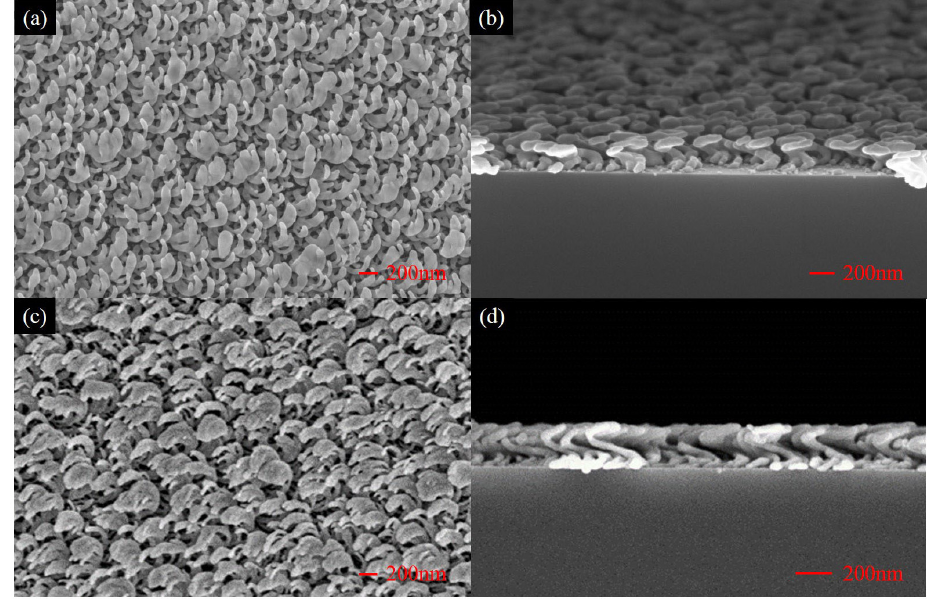
Figure 4. Top-view and cross-section SEM images of Ag nanohelix arrays deposited at substrate temperatures of ( a , b ) 10 °C and ( c , d ) − 140 °C. Table 3. Pitch length ( p ), wire diameter ( d ), radius of curvature ( R ), and density ( n ) of sample ‐ Tj , j = 1, 2.